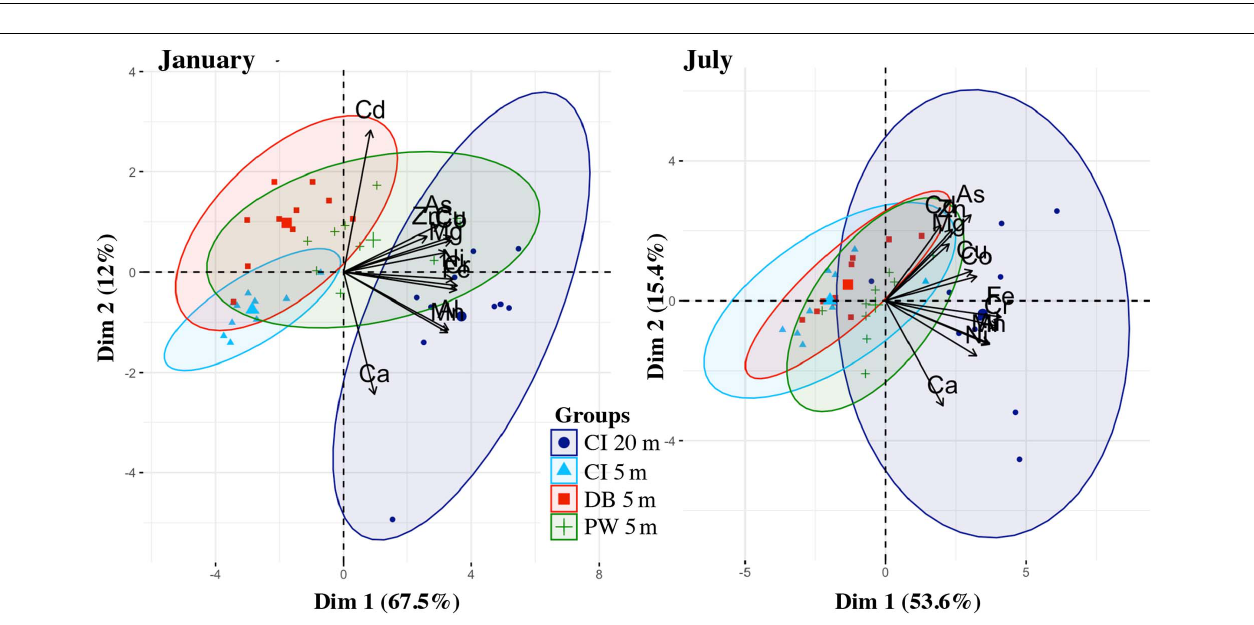
FIGURE 12 | PCA of the trace metals data from oysters from January and July, colored by location (Carr Inlet 20 m = dark blue, Carr Inlet 5 m = light blue, Dabob Bay 5 m = red, Point Wells 5 m = green).